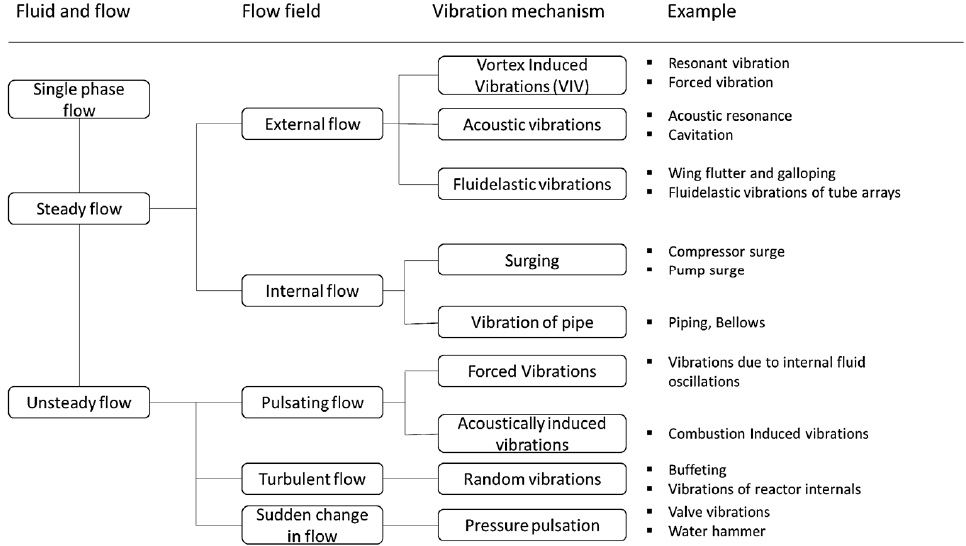
Figure 1. Classification of flow-induced vibrations.